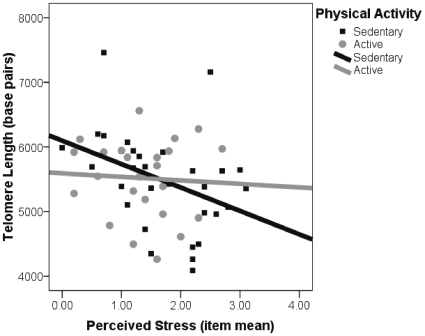
Relationship between perceived stress and telomere length as a function of physical activity.Note. Physical activity categories are based on whether the participant met CDC recommended levels of exercise per week. Perceived stress ratings are based on the Perceived Stress Scale. The relationship between perceived stress and telomere length was significant in sedentary participants only.